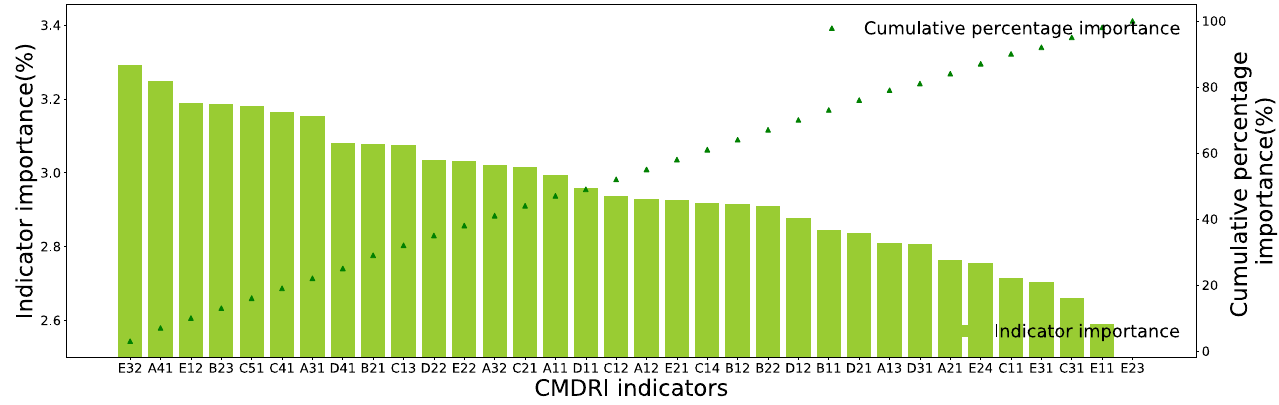
Figure 4. Permutation importance of each indicator in the RF model.